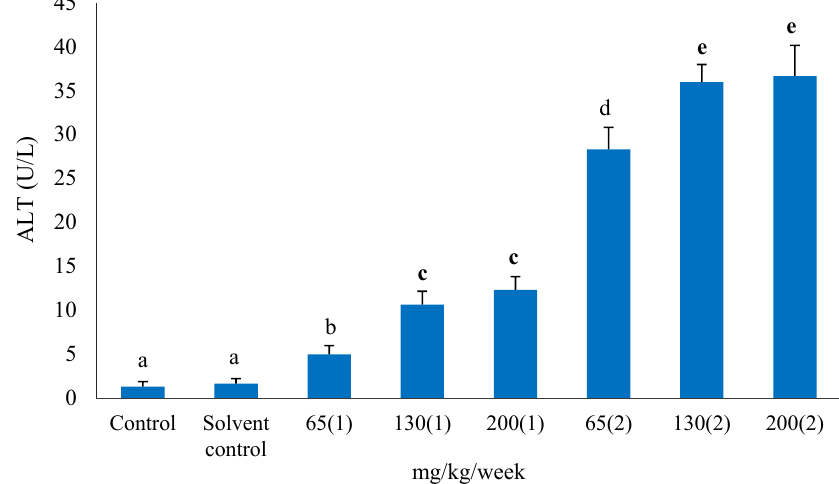
Fig. 5: Means ± SD for alanine transaminase (ALT) (unit/L) in the Caspian kutum exposed to fipronil for 7 (1) and 14 (2) days gene expression in larval fathead minnow exposed to fipronil for 24